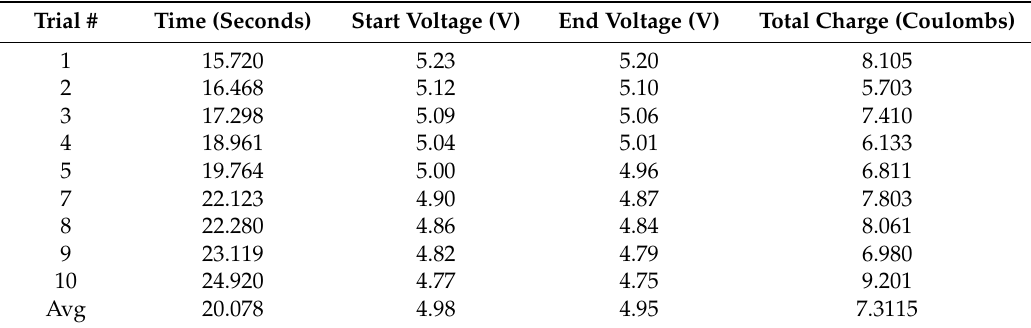
Table 3. Raw distance test